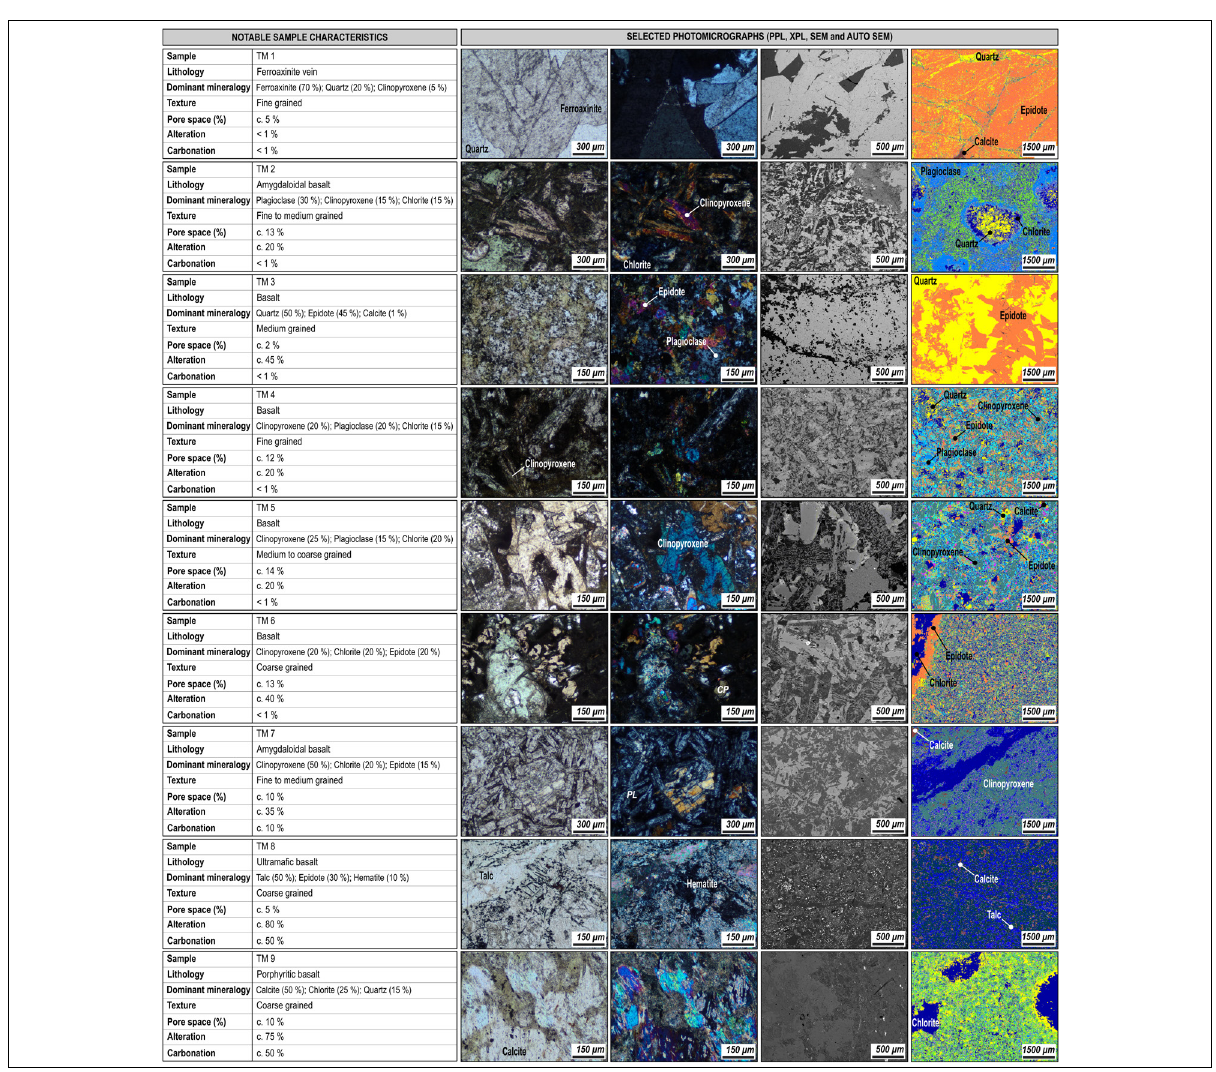
Figure 6: Overview of petrographic analyses and photomicrographs of samples of the Ventersdorp Supergroup sequences. Photomicrographs include optical microscopy in plane polarised light (PPL), cross-polarised light (XPL), and automated (Auto SEM) and scanning electron microscopy (SEM). Information is also provided on characteristic